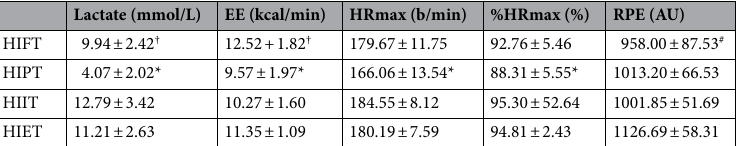
Table 8. Markers of training intensity and internal load. Data are presented as mean ± SD of all sixteen sessions. *p ≤ 0.01 in comparison to all groups. † p ≤ 0.05 in comparison to all groups. # p ≤ 0.05 in comparison to